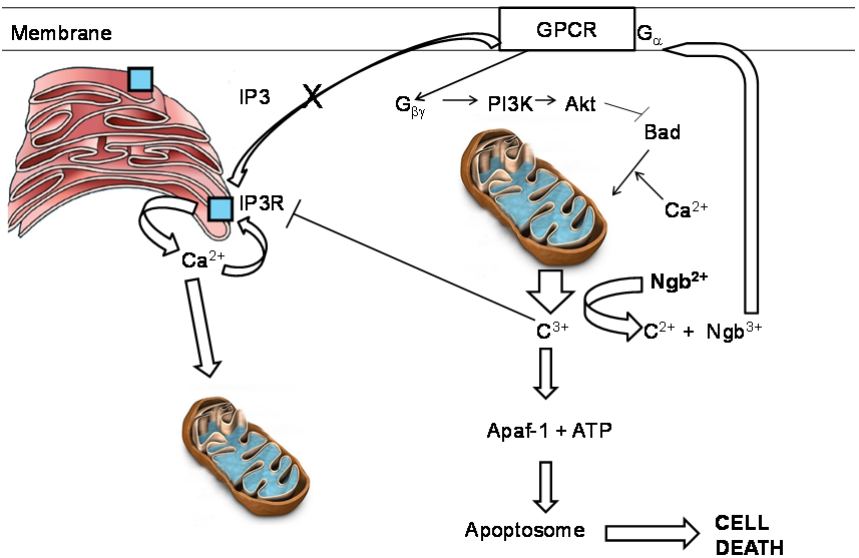
Figure 4. A hypothetical interpretation of the know reactivities of neuroglobin in the suppression of apoptotic activity. C3+ and c2+ represent the oxidized and reduced forms of cytochrome c